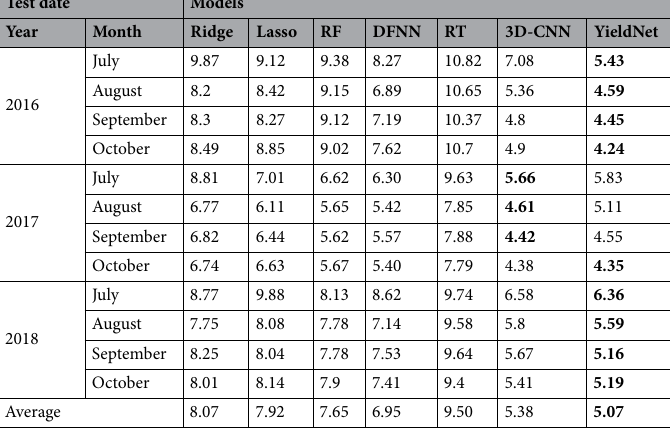
Table 5. The RMSE of soybean yield prediction performance of models. The average ± standard deviation for corn yield in years 2016, 2017, and 2018 are, respectively, 53.94 ± 7.23 , 50.24 ± 8.72 , and 53.17 ± 9.72 . The numbers of test samples in years 2016, 2017, and 2018 for soybean yield prediction are 773, 776, and 663, respectively. The unit of RMSE is bushels per acre. Best results are given in